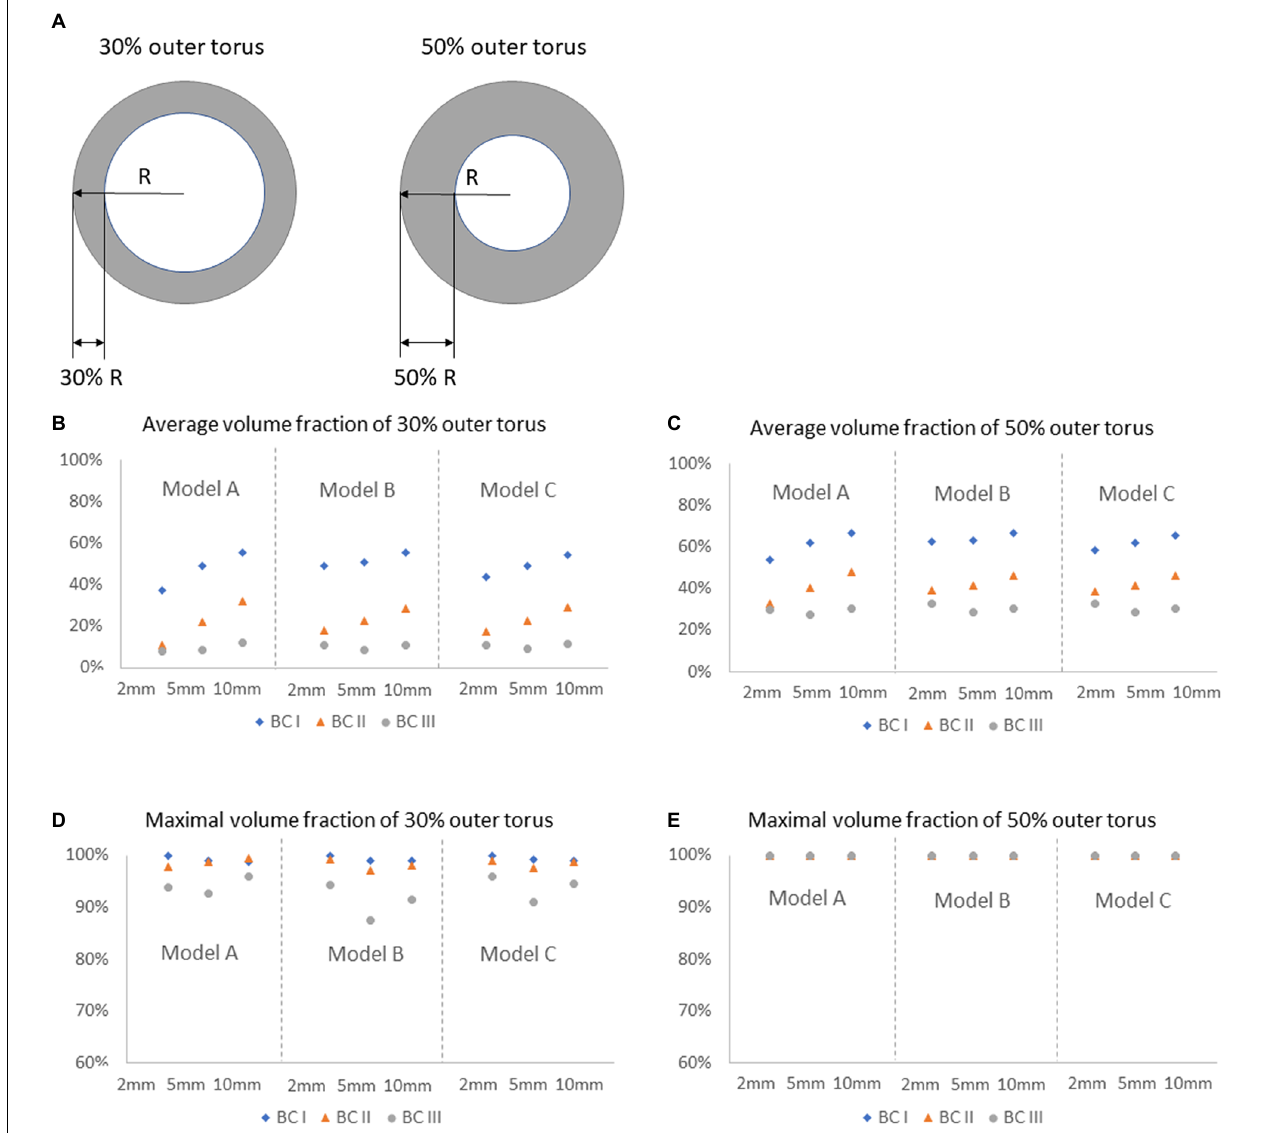
FIGURE 7 | Comparison of average and maximal volume fractions of flush flow on different cross-sectional planes, in 30 and 50% outer torus, under three flowrates of the background blood flow, for Models A, B, and C. (A) Sketch of the 30 and 50% outer torus. (B) Average volume fraction of 30% outer torus. (C) Average volume fraction of 50% outer torus. (D) Maximal volume fraction of 30% outer torus. (E) Maximal volume fraction of 50% outer torus.